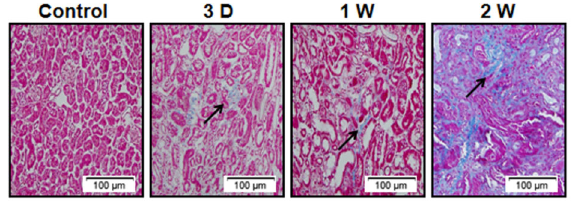
Figure 1. Masson staining of the kidney tissue. Samples were scored according to the scoring system using Masson staining: 0, no fibrosis; 1, mild fibrosis (10-30% in area); 2, moderate fibrosis (30-50% in area); 3, severe fibrosis ( . 50% in area). Based on the average extent of histological change, the samples at 3 days post-surgery were scored 0-1, at 1 week were scored 1, and at 2 weeks were scored 3. Arrows show fibrotic areas.